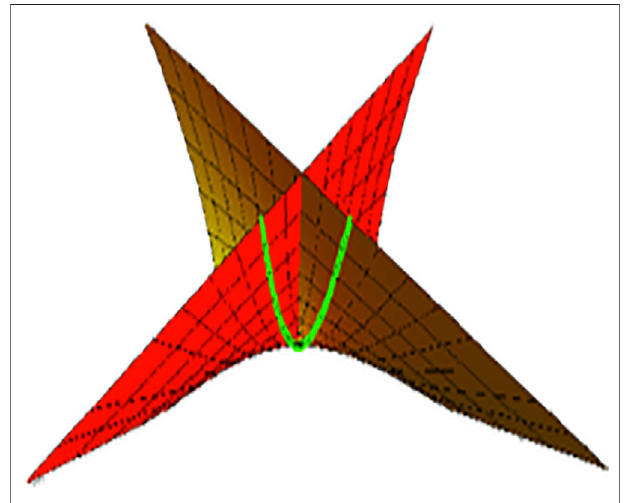
FIGURE 2 | Timelike-ruled surface, ϑ ( t ) = t .